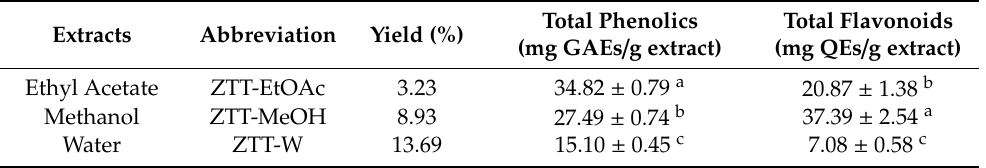
Table 1. Abbreviation, extraction yield, and total phenolic and flavonoid content of the solvent extracts from Z. taurica subsp. taurica x